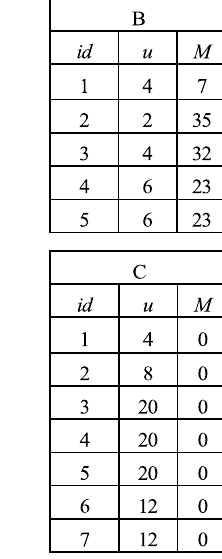
Fig. 3 UL structures of 1-item- set